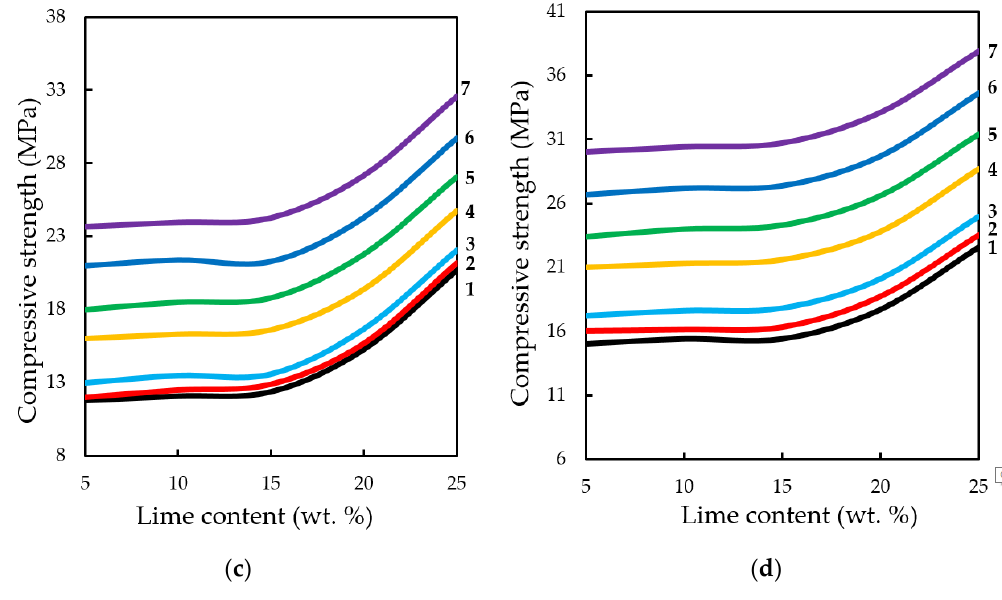
Figure 16. Variation in the compressive strength of testing samples manufactured at pressing pressure of: ( a ) 10; ( b ) 20; ( c ) 30; ( d ) 40 MPa. Samples carbonated by static method during 900 s, depending on the content of Ca(OH) 2 and concentration of СО 2 , %: 1— 10; 2— 20; 3 —30; 4— 40; 5 —50; 6 —60; 7 —65. The authors would like to apologize for any inconvenience caused to the readers by these changes.